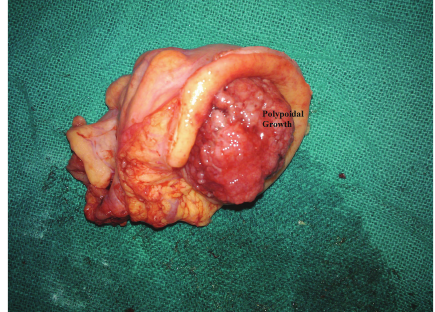
Figure 4: Resected specimen showing the polypoid growth with irregular luminal surface in the descending